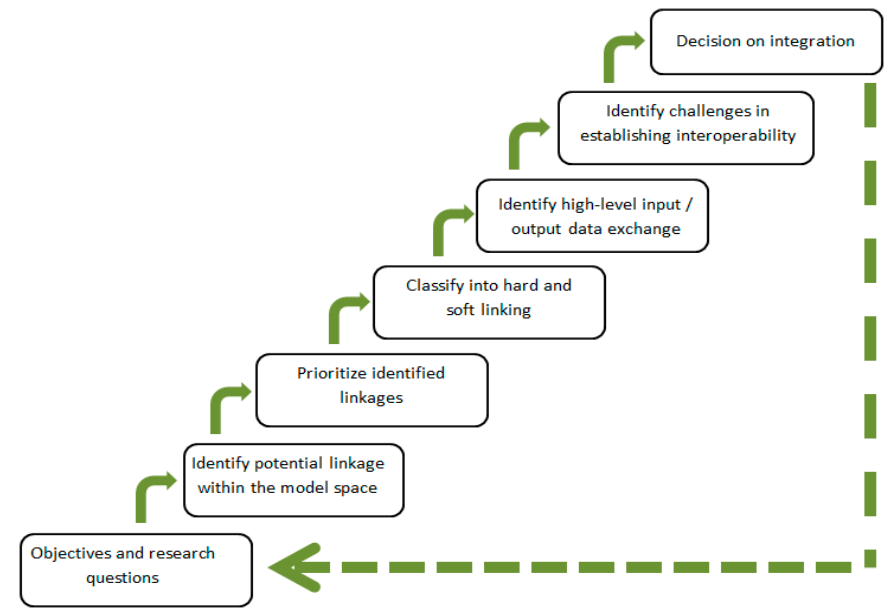
Figure 1. Steps of the pre-integration assessment process within a certain collection of models.